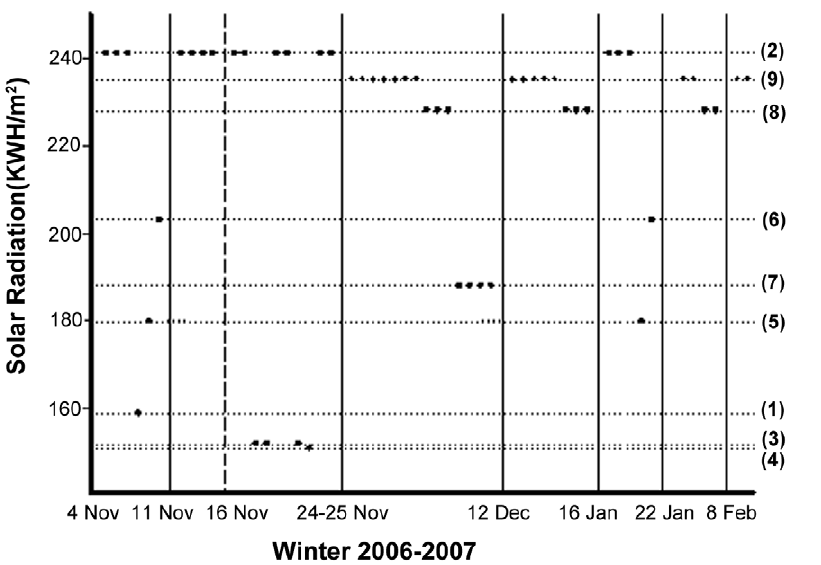
Figure 4. Monkeys were found in MAPs with highest solar radiation following snowfalls during the snowy period of our winter 2006–2007 survey. MAPs are arranged according to mean solar radiation and are indicated by number in parenthesis on the right vertical axis (Appendix S1, Table 1). Black dots indicate the locations of monkeys. Snowfalls are indicated by vertical lines and correspond to dates on the x-axis. The dotted vertical line indicates a short, 1–2 h snowfall during the day.